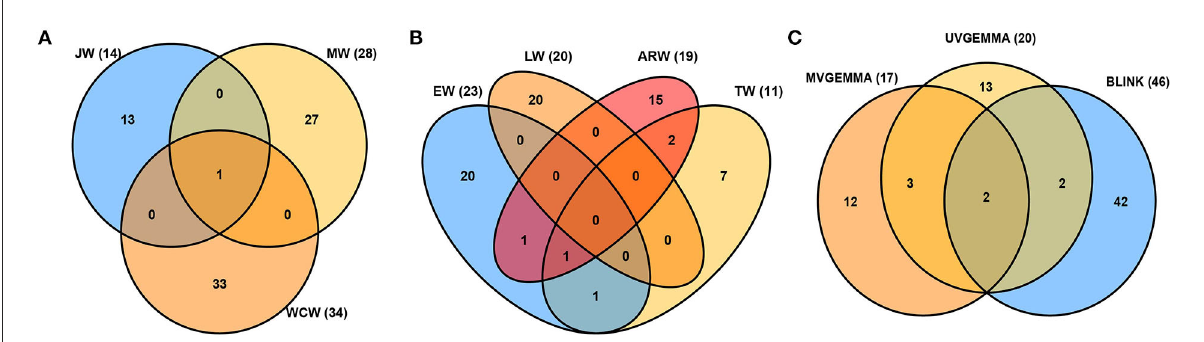
FIGURE4 Venn diagrams of associated single-nucleotide polymorphisms (SNPs) detected for all traits. (A) Juvenile wood (JW), mature wood (MW), and whole core wood (WCW). (B) Earlywood (EW), transition wood (TW), latewood (LW), and annual ring wood (ARW). (C) Comparison of the